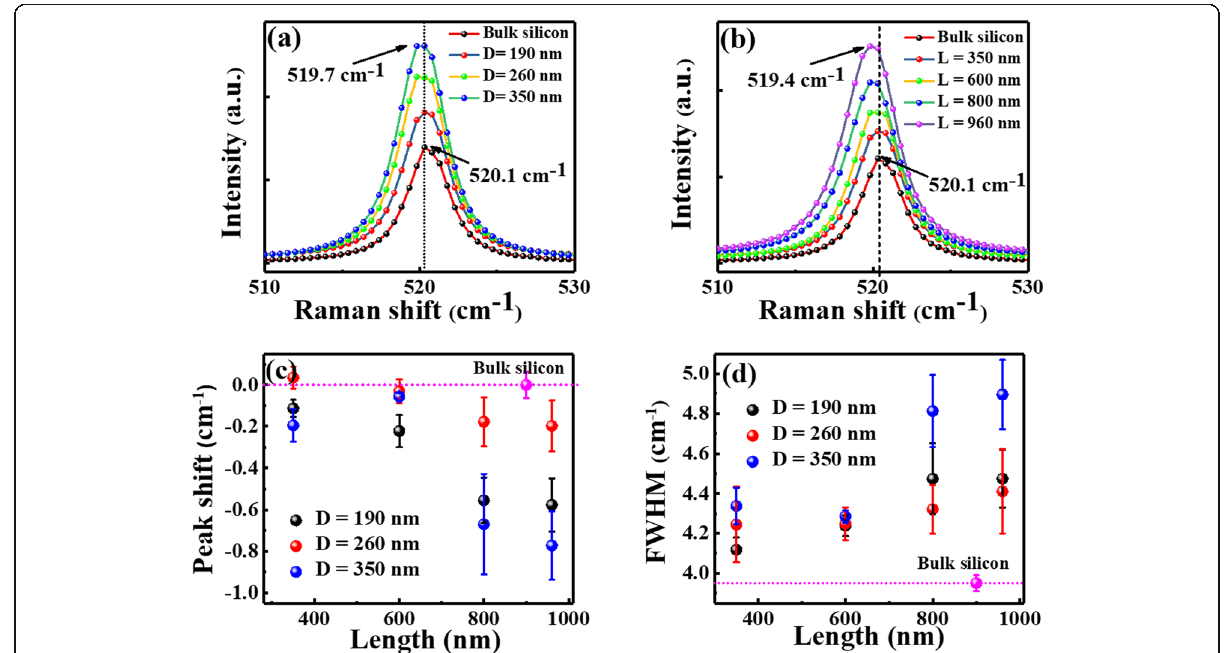
Fig. 3 Typical Raman spectra of bulk Si and Si nanowires with a same length of 350 nm but different diameters and b same diameter of 190 nm but different lengths. c and d represent the redshift of peak position and the FWHM broadening as a function of nanowire